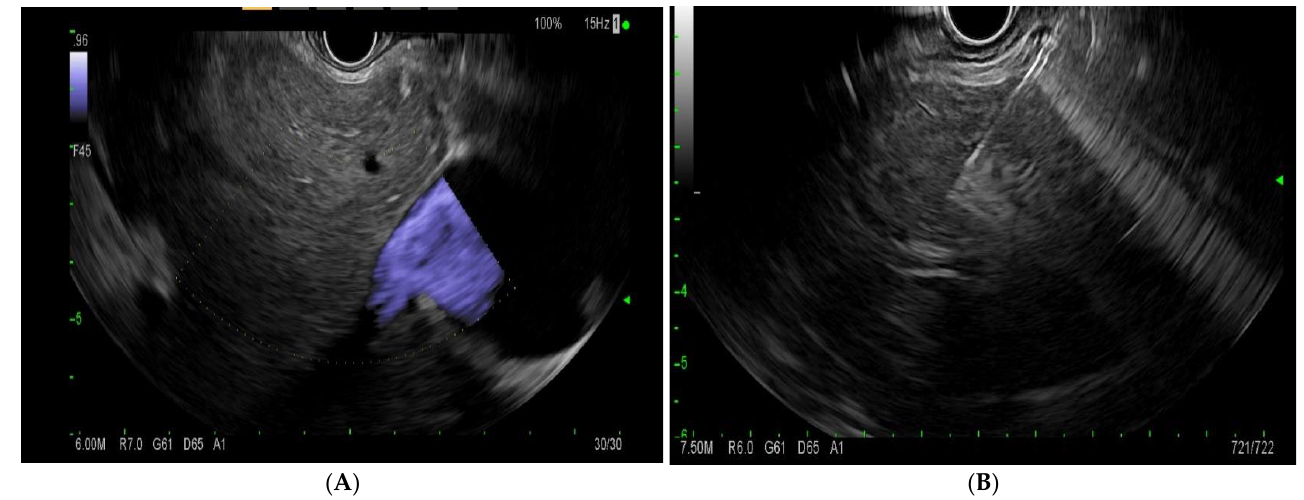
Figure 4. ( A ) — endoscopic ultrasound image of the liver with doppler. ( B ) — endoscopic-ultrasound- Figure 4. ( A )—endoscopic ultrasound image of the liver with doppler. ( B )—endoscopic-ultrasound- guided liver biopsy using a 19 G needle. guided liver biopsy using a 19 G